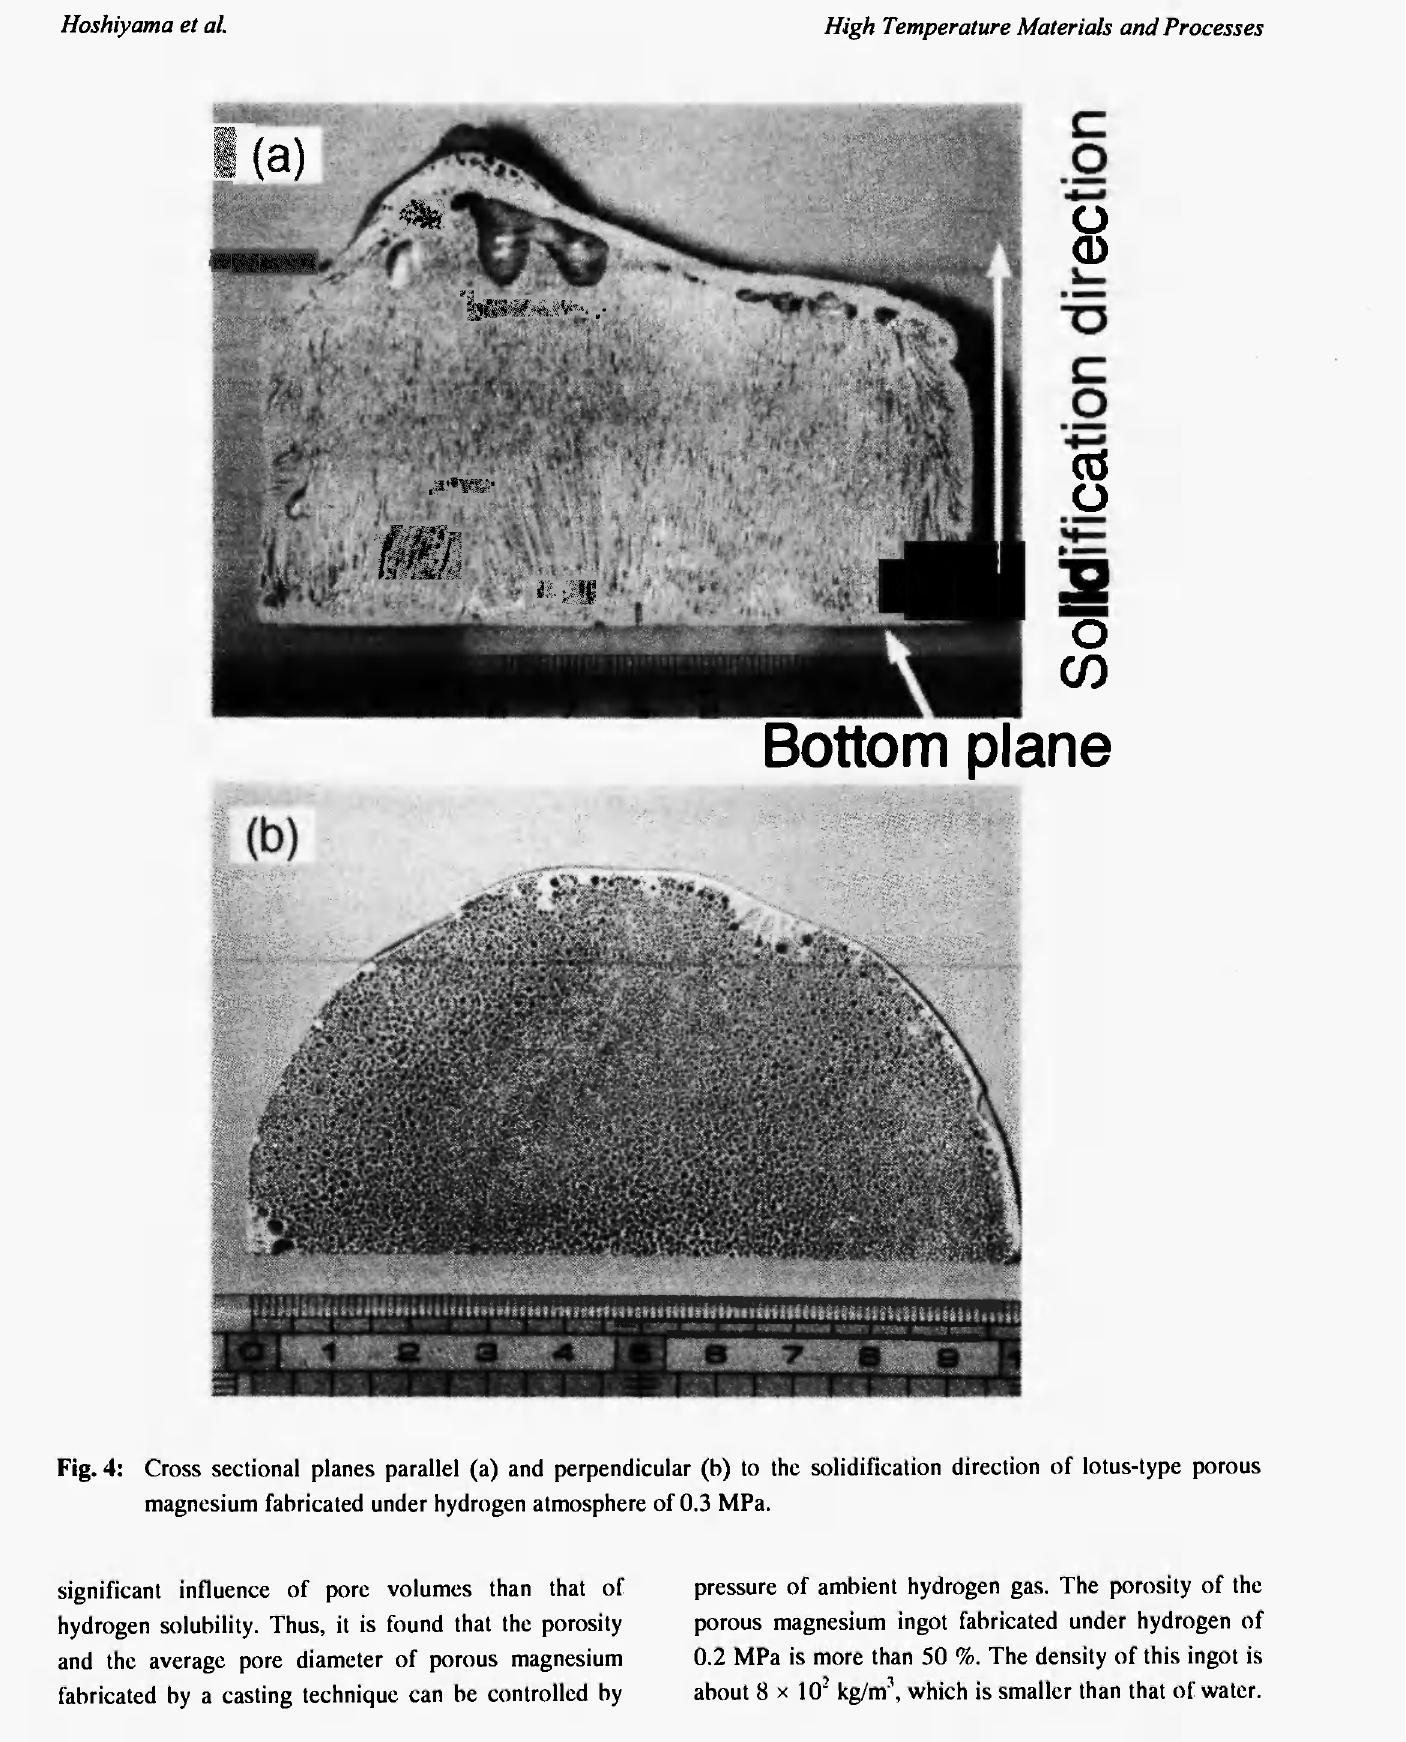
Fig. 4: Cross sectional planes parallel (a) and perpendicular (b) to the solidification direction of lotus-type porous magnesium fabricated under hydrogen atmosphere of 0.3 MPa.